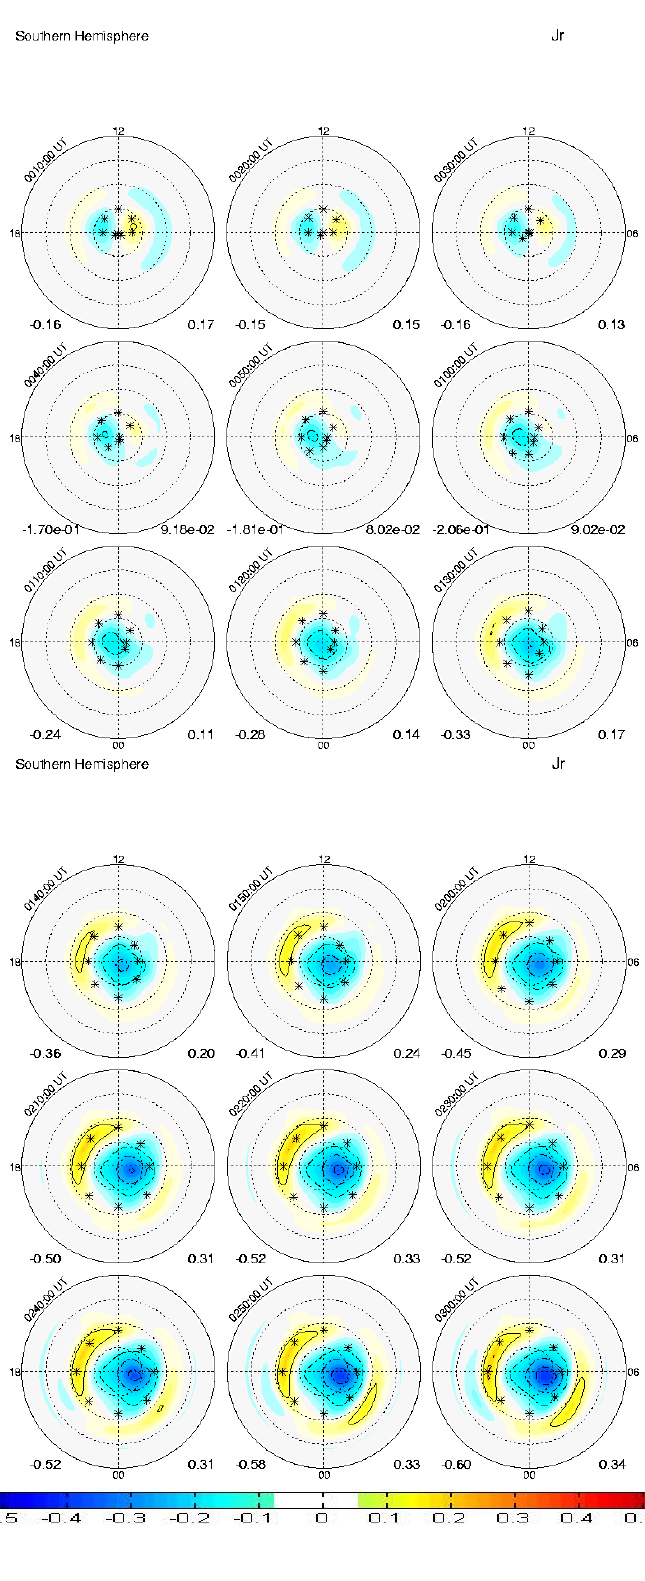
Fig. 4. Field-aligned currents ( µ A/m 2 ) in the Southern (i.e. summer) Hemisphere under varying northward and duskward IMF. The color coding shows the field-aligned current densities and the contours indicate equal current density. The asterisks mark the open/closed field line